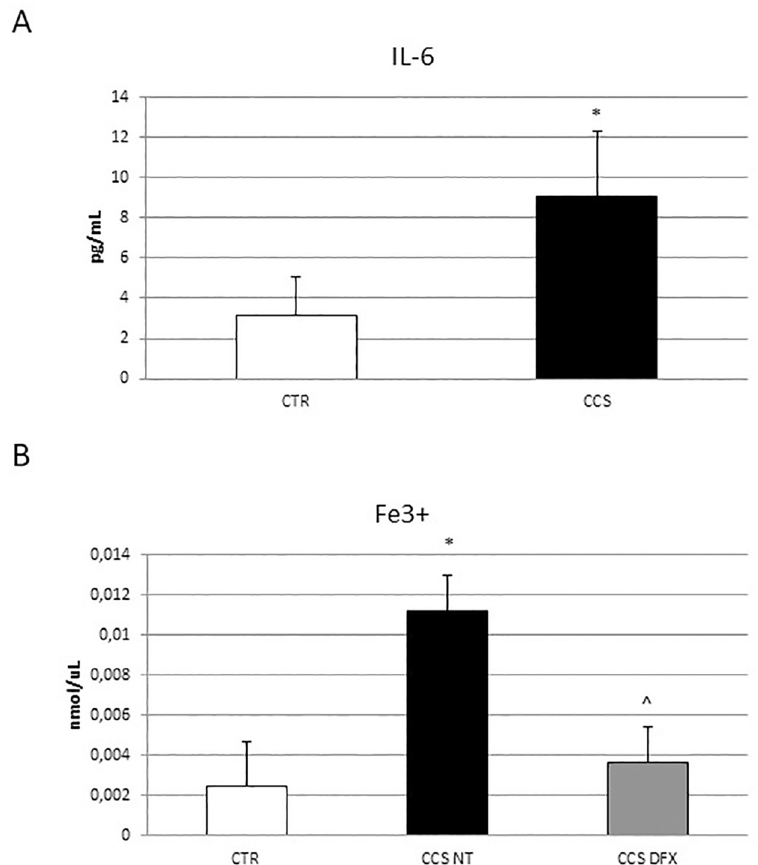
Fig 3. IL-6 and iron release in OCs derived from CCS. (A) Concentration of IL-6 (pg/mL) in 5 Childhood cancer survivors (CCS) compared to OCs from 5 healthy subjects (CTR) determined by ELISA Assay. Histogram shows concentration of IL-6 expressed as mean ± S.D. of independent experiments on each individual sample. Concentration of cytokine was calculated on a standard concentration curve. For statistical analysis it has been used a t-test. � Indicates p � 0.05 compared to CTR. (B) Fe3+ intracellular concentrations (nmol/ μ L) in 5 Childhood cancer survivors (CCS) before and after Deferoxamine (DFX) [5 μ M] administration compared to OCs from 5 healthy subjects (CTR) detected by Iron Assay. Histogram shows concentration of Fe3+ expressed as the mean ± SD of independent experiments on each individual sample. For statistical analysis it has been used ANOVA test followed by a post hoc test. � Indicates p � 0.05 compared to CTR. ^ indicates p � 0.05 compared to CCS